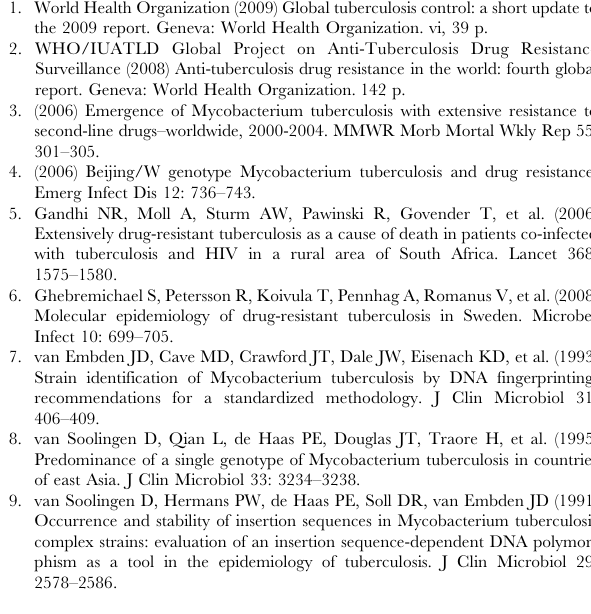
Table S1 Complete list of LSPs compared to H37Rv. (XLS) Table S2 Complete list of DIPs compared to H37Rv. (XLS) Table S3 Complete list of SNPs compared to